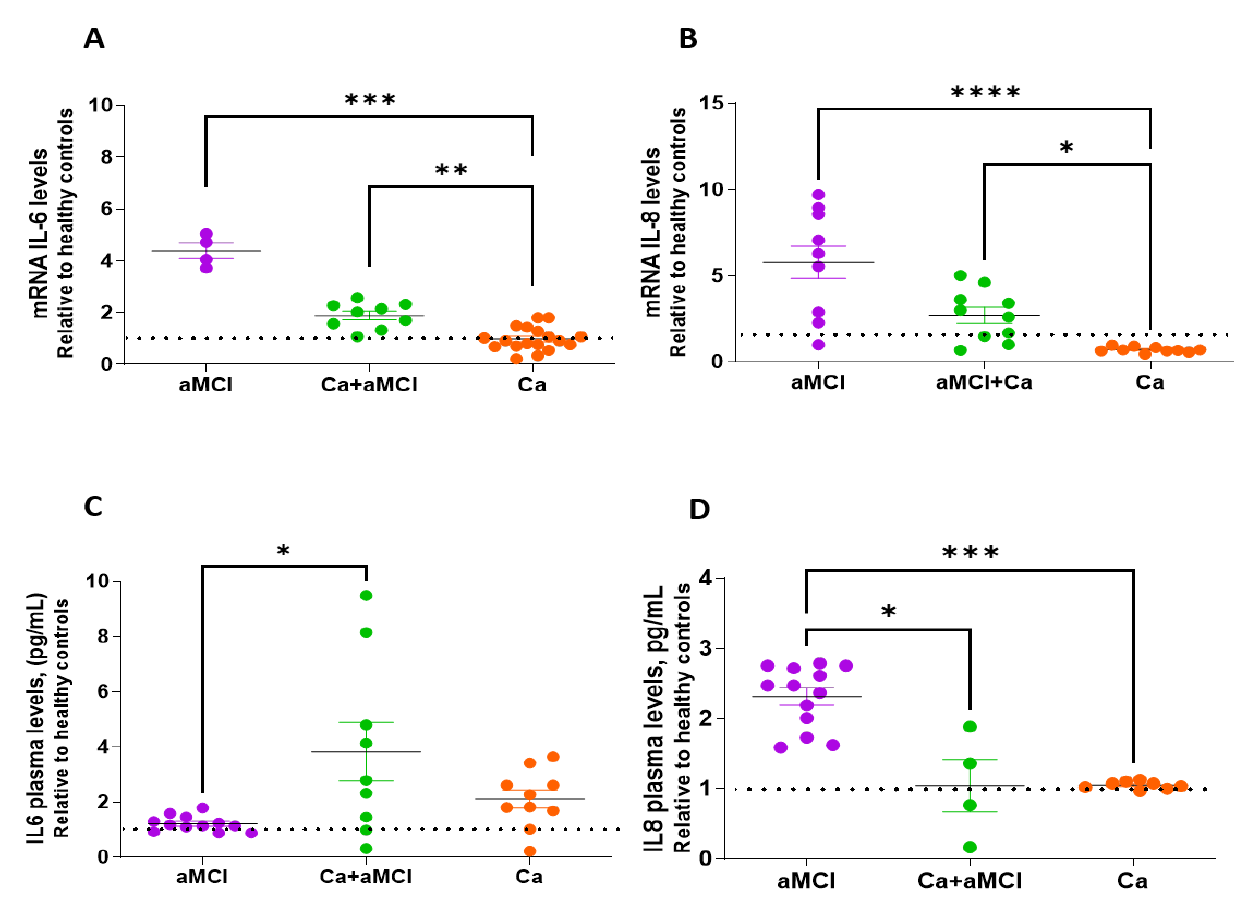
Figure 5. mRNA expression by PBMCs and plasmatic levels of IL-6 and IL-8 in patients with MCI, Ca + aMCI, and cancer survivors, relative to healthy control levels. ( A , B ): mRNA expression levels of cytokines IL-6 ( A ) and IL-8 ( B ) determined by qPCR in PBMCs of aMCI (n = 5), Ca + aMCI (n = 9), and Ca survivor (n = 18) patients expressed relative to healthy controls (dotted line, 565.6 ± 65.5 and 2.8 ± 0.3 Units, mean ± SE, for IL-6 and IL-8, respectively). The increased mRNA expressions of cytokines IL-6 and IL-8 by PBMCs of aMCI patients were not present in Ca + aMCI patients, nor in Ca survivors. PBMCs of Ca survivors had significantly lower mRNA expressions of both cytokines compared with aMCI and Ca + aMCI. ( C , D ): Plasmatic levels of IL-6 ( C ) and IL-8 ( D ) relative to healthy control values (dotted line, 0.54 ± 0.01 and 1.23 ± 0.02 pg/mL, mean ± SE, for IL-6 and IL-8, respectively) were measured by ELISA in PBMCs of aMCI (n = 12), Ca + aMCI (n = 9 for IL-6 and n = 4 for IL-8) and Ca survivors (n = 10 for IL-6 and n = 8 for IL-8). Statistical analysis: Kruskal–Wallis with Dunn’s post hoc correction, * p < 0.05, ** p < 0.01, *** p < 0.005, **** p < 0.001.